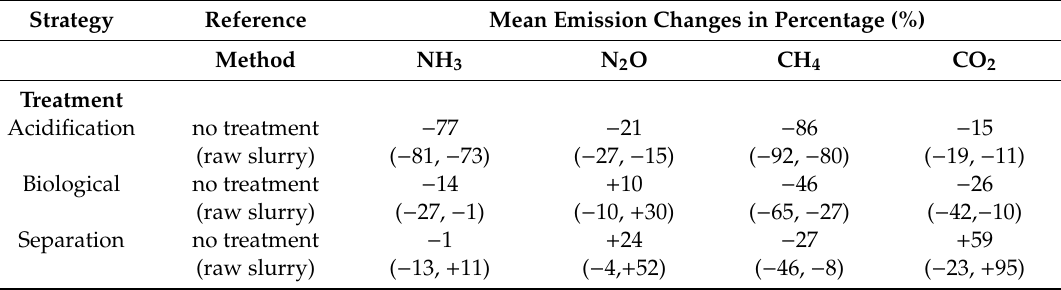
Table 2. Results of the meta-analysis of greenhouse gas (GHG) emission changes, following reduction strategiesacrossdi ff erentmanuretreatmentstrategies(numbersinbracketsrepresentthe95%confidence intervals). Negative values represent emission reduction, and positive values show increase in